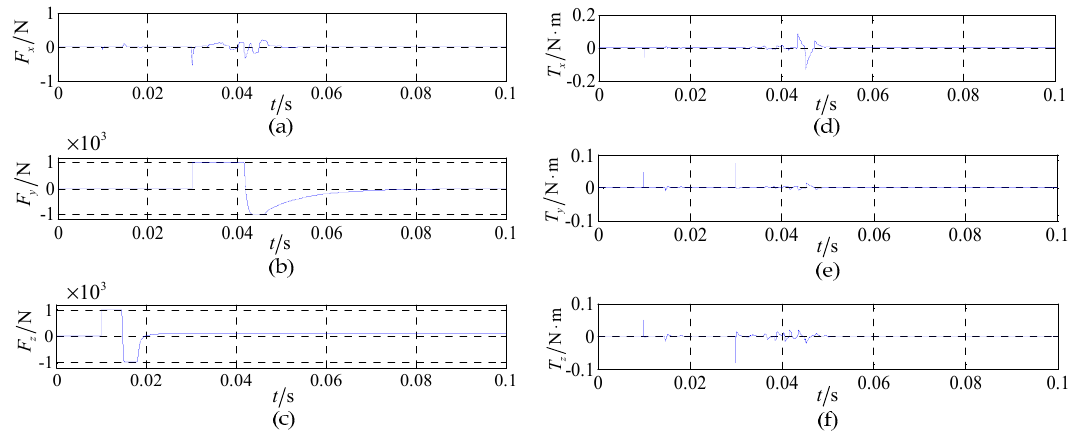
Figure 12. Force and torque curve of the control system based on the interpolation method.